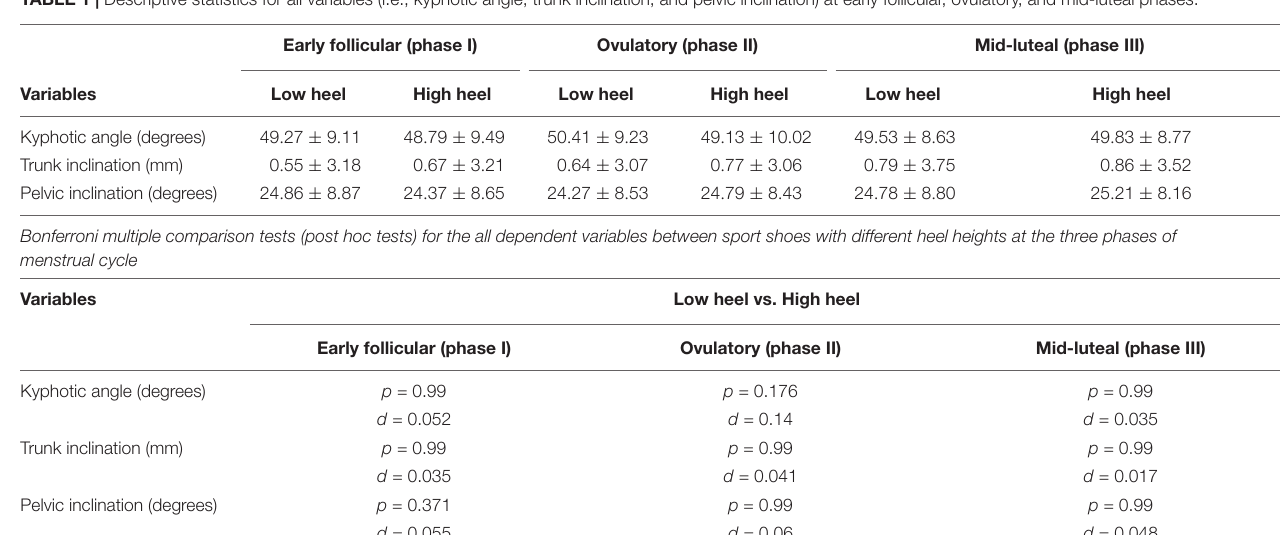
TABLE 1 | Descriptive statistics for all variables (i.e., kyphotic angle, trunk inclination, and pelvic inclination) at early follicular, ovulatory, and mid-luteal